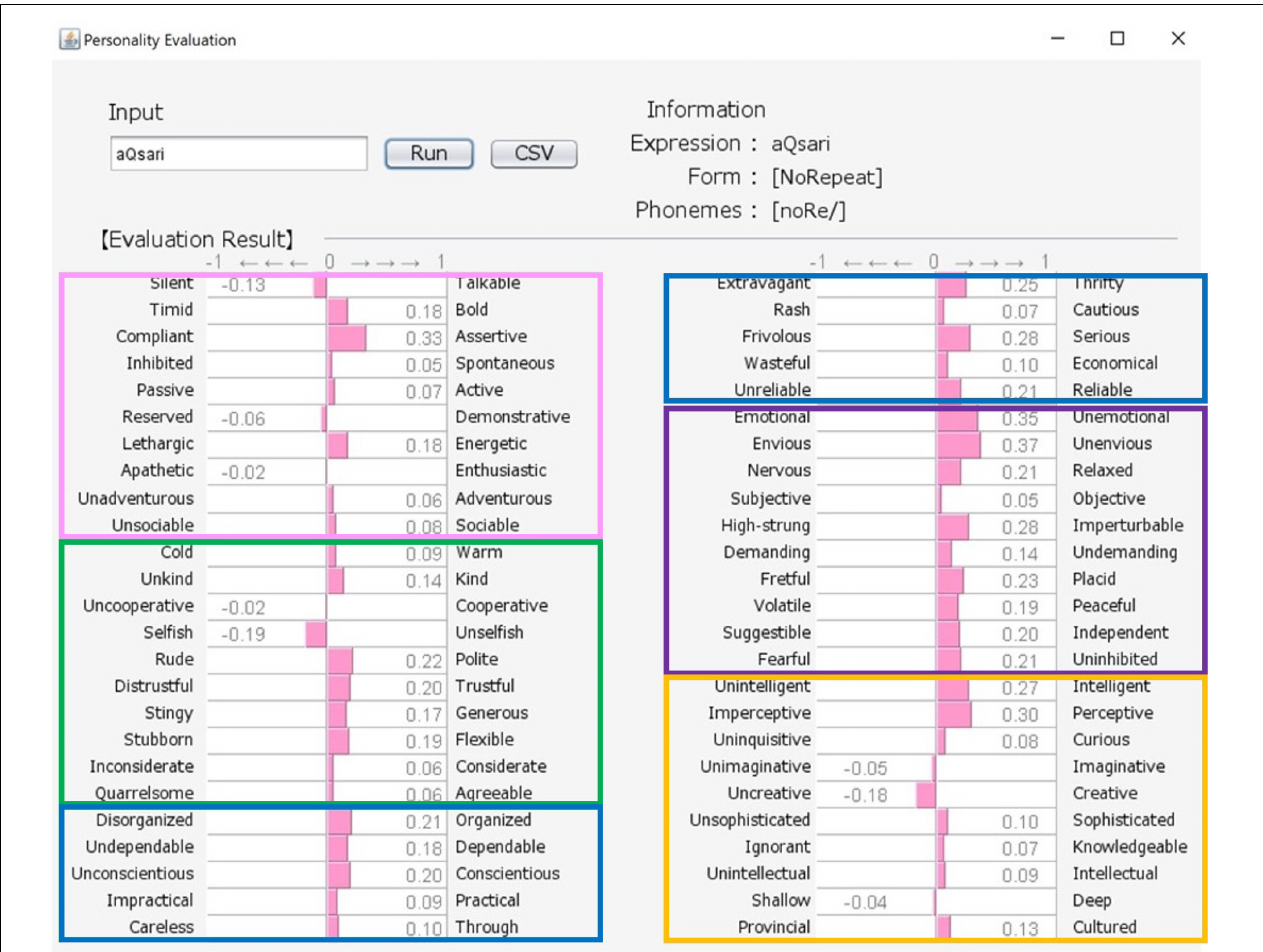
FIGURE 8 | Output for “assari (standoffish)” personality. The pink, green, blue, purple, and orange frames indicate Extroversion, Agreeableness, Conscientiousness, Neuroticism, and Openness, respectively.